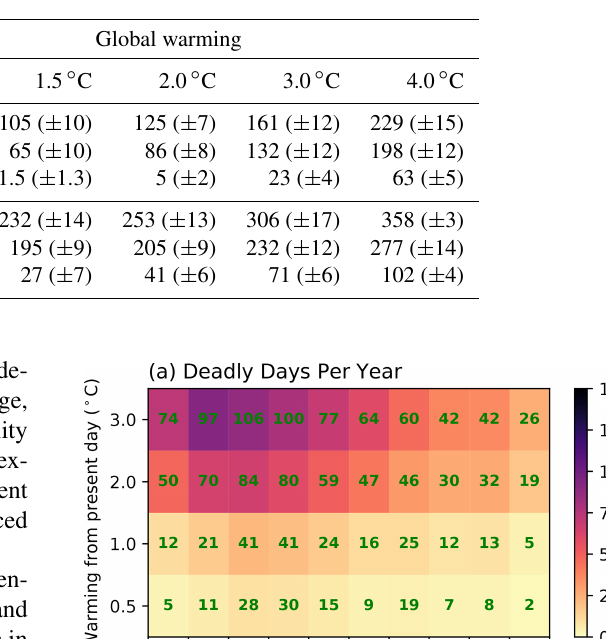
Table 3. Number of deadly days each percentile (p.) of the global population faces, with reference period (0.87 ◦ C) and 1.5, 2, 3, and 4 ◦ C of global warming from the preindustrial condition. Standard deviations between the ensembles (1 σ ) are also shown.